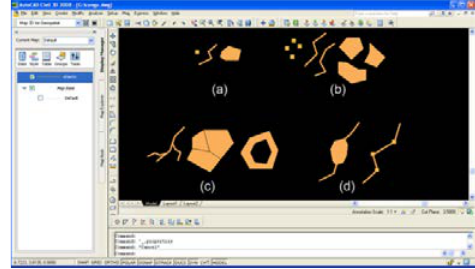
Figure 9. CONGOO objects created into AutoCad Map’s model